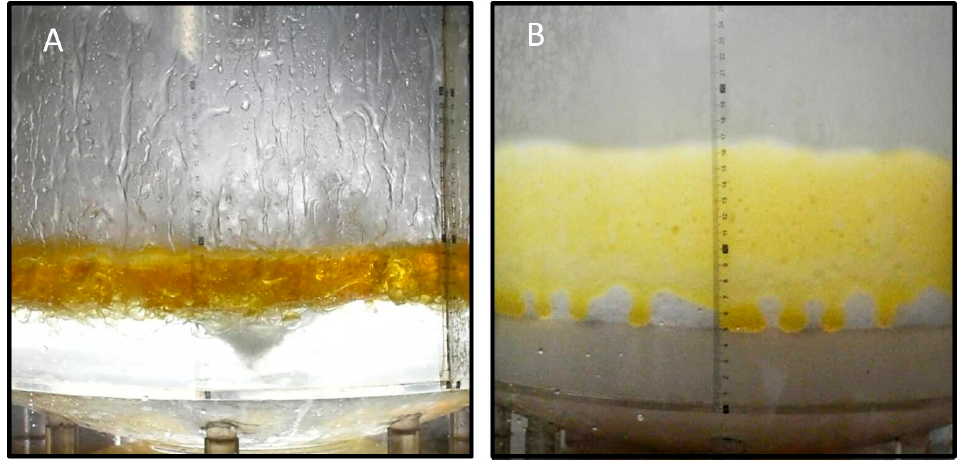
Figure 12. Cavity shape with the coverage of liquid slag and foaming slag. ( A ). liquid slag; ( B ). foaming slag.